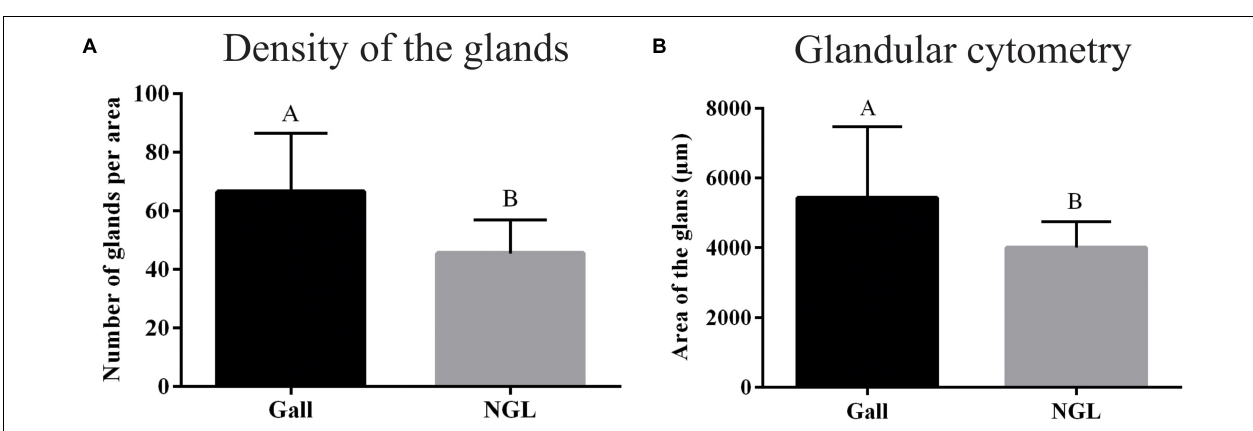
FIGURE 3 | Quantitative analysis of glands. (A) Density of the glands per mm 2 . (B) Glands area. NGL: Non-galled